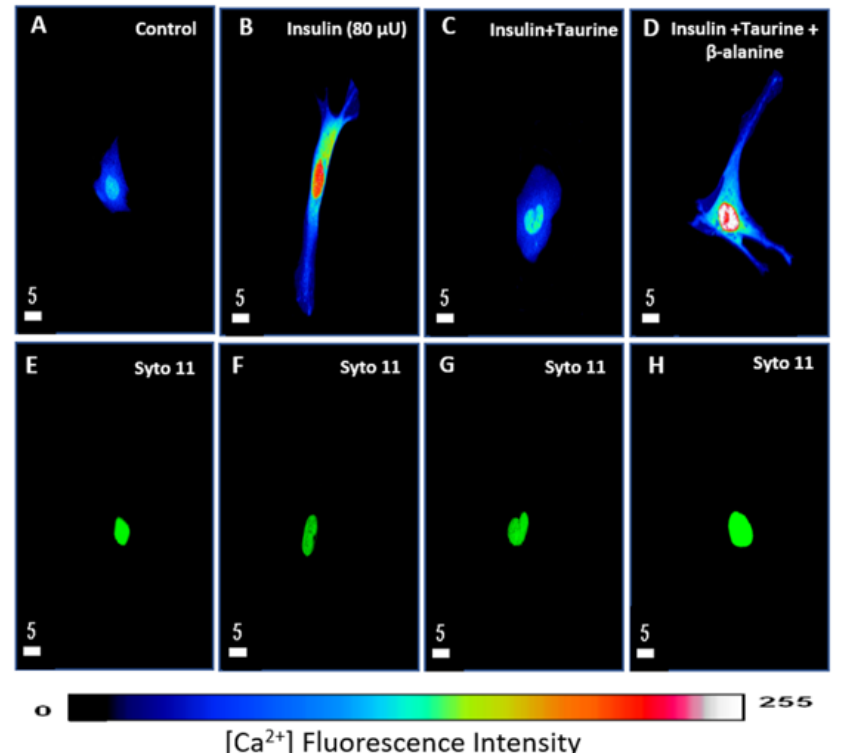
Figure 6. Examples of quantitative 3-D confocal images (top view) showing the distribution and fluorescence intensity of intracellular calcium levels in cardiomyocytes in the absence of treatment ( A ), in the presence of insulin (80 μ U/mL) ( B ), in the presence of insulin (80 μ U/mL) + taurine (20 mM) ( C ), and in the presence of insulin (80 μ U/mL) + taurine (20 mM) + β -alanine (500 μ M) ( D ). ( E – H ) represent the Syto-11-labeled nuclei of the cells in ( A – D ). The pseudo-color bar represents Ca 2+ fluorescence intensity ranging from 0 (absence of fluorescence) to 255 (maximum fluorescence). The white scale bar is in μ M.